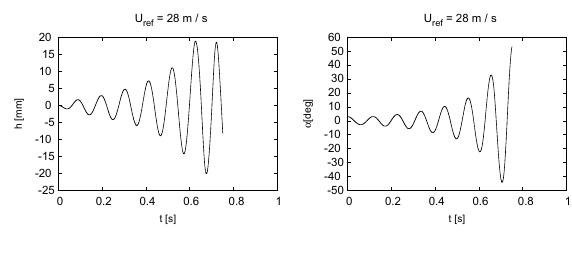
Fig. 11. Aeroelastic response for the seconde considered case in terms of h and α in time domain for far field velocity U ∞ = 15 m / s